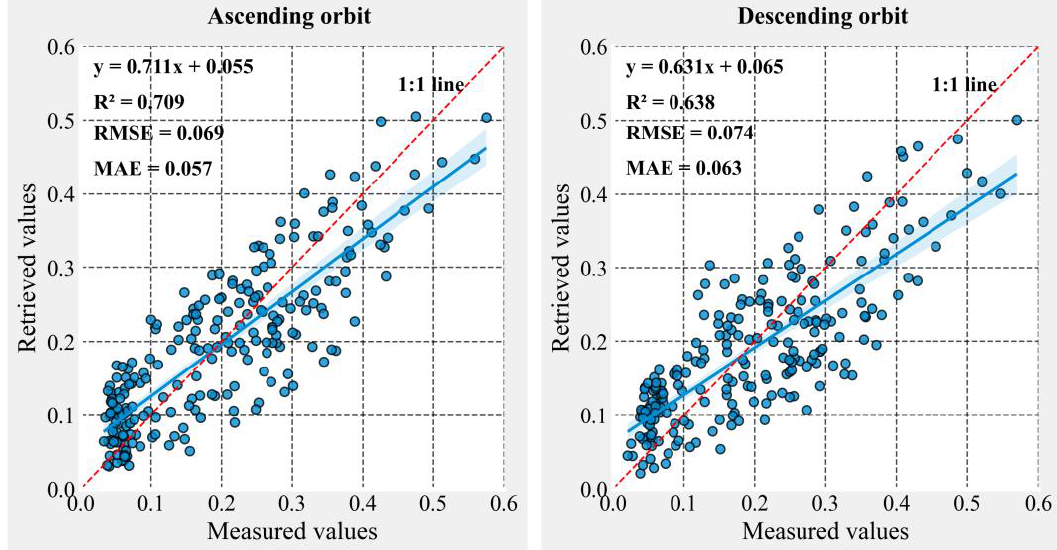
Figure 15. Comparision between measured and retrieved soil moisture values for Tianjun network (The blue line is fitted line, and the red line is 1:1 line).